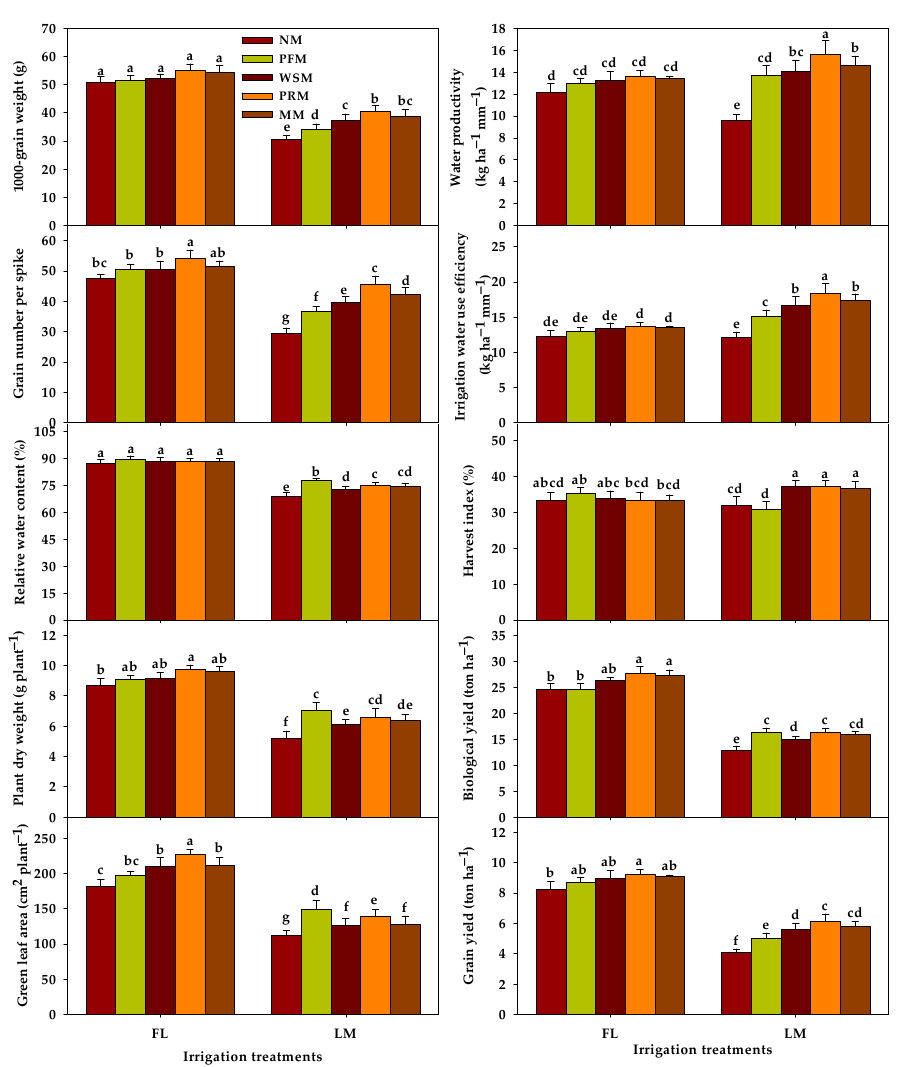
Figure 5. Response of different traits of wheat to the interaction between mulching practices and irrigation regimes in 2019 − 2020 growing season. Abbreviations in the figure indicate no mulch (NM), plastic film mulch (PFM), wheat straw mulch (WSM), palm residues mulch (PRM), and a mixture of wheat straw and palm residues at 50/50 ratio (MM), full irrigation regime (FL, 1.00 ET) and limited irrigation regime (LM, 0.50 ET). The different letters indicate statistical significance at the 0.05 level.